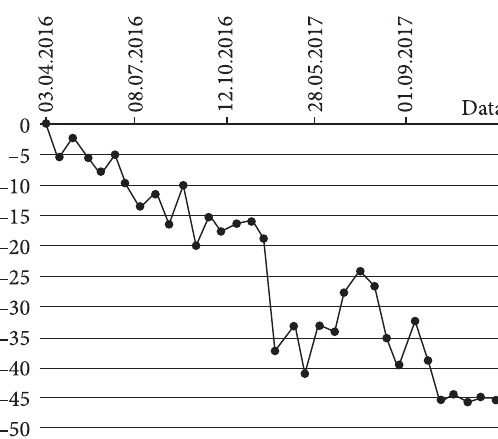
Figure 5. Dynamics of the vertical displacement at the point No.